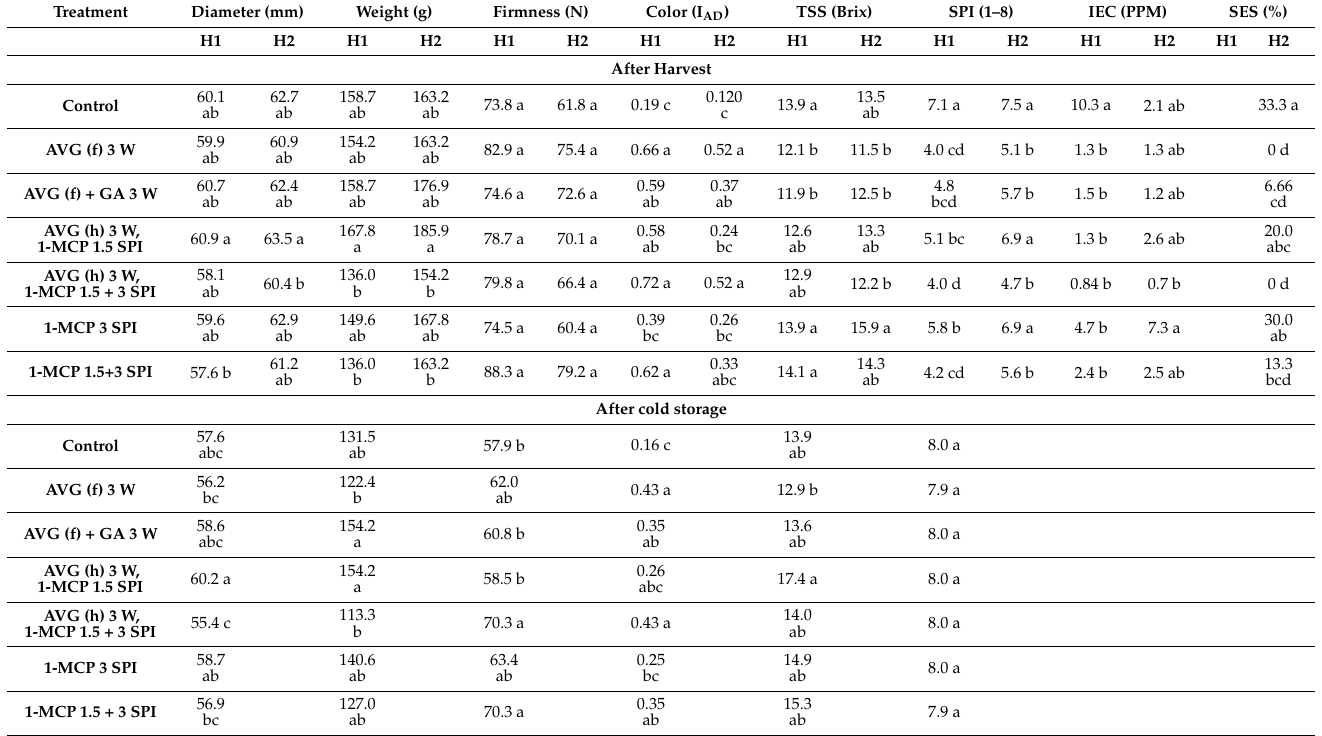
Table 3. Effects of AVG and 1-MCP on the fruit quality of ‘Buckeye Gala’ apples at harvest and after cold storage, 2021, Exp.